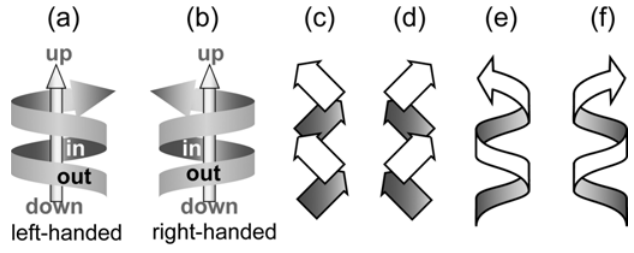
Figure 13. Helices with three directions; up and down, in and out, as well as right and left. Right-handed helix (a) and left-handed helix (b). 2 Helical assemblies of molecules 1 with three-axes; left-tilt, left-handed helix (c) and right-tilt, right-handed helix (d). Ribbon-like expression of the left-handed helix (e) and right-handed helix (f).